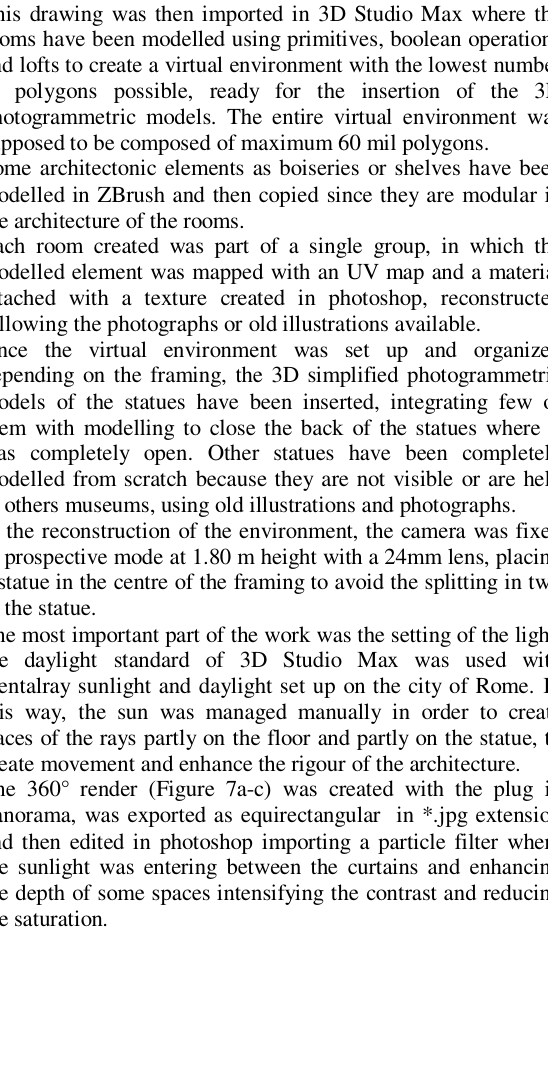
Figure 6. The process followed for the virtual reconstruction of the rooms of the Museums, as they were in the 18 th century: (a) examination of the photos; (b) extraction of the profiles; (c) drawing and extrusion in CAD